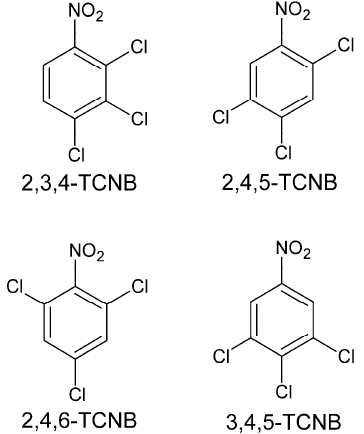
Figure 1. Structures of the four trichloronitrobenzenes (TCNBs) used in this study.